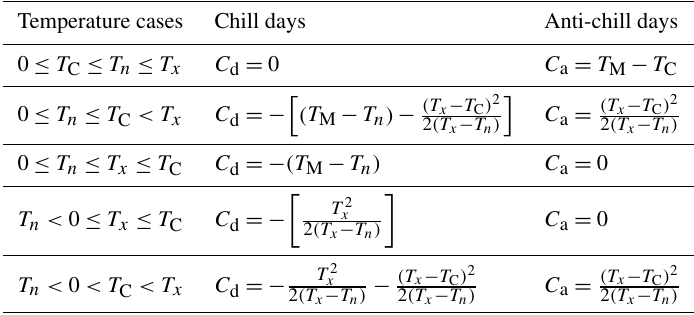
Table A1. Chill day ( C d ) and anti-chill day ( C a ) calculation for five different temperature cases relating maximum ( T x ) and minimum ( T n ) air temperature to the air temperature threshold ( T C ) and 0 ◦ C; T M is the air mean temperature. Temperature